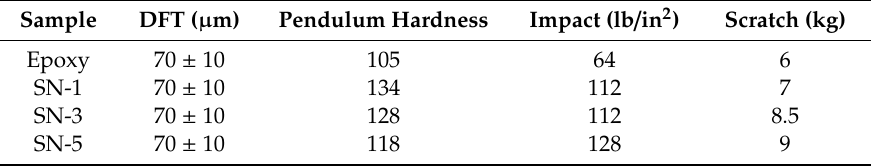
Table 4. Mechanical properties of epoxy and silica modified epoxy coatings. Sample Pendulum